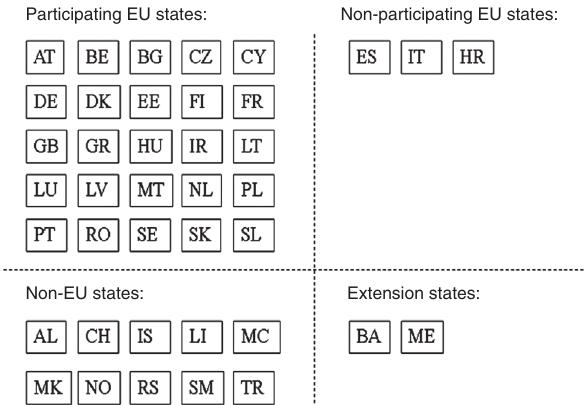
Figure 2 Member States and Extension States of the